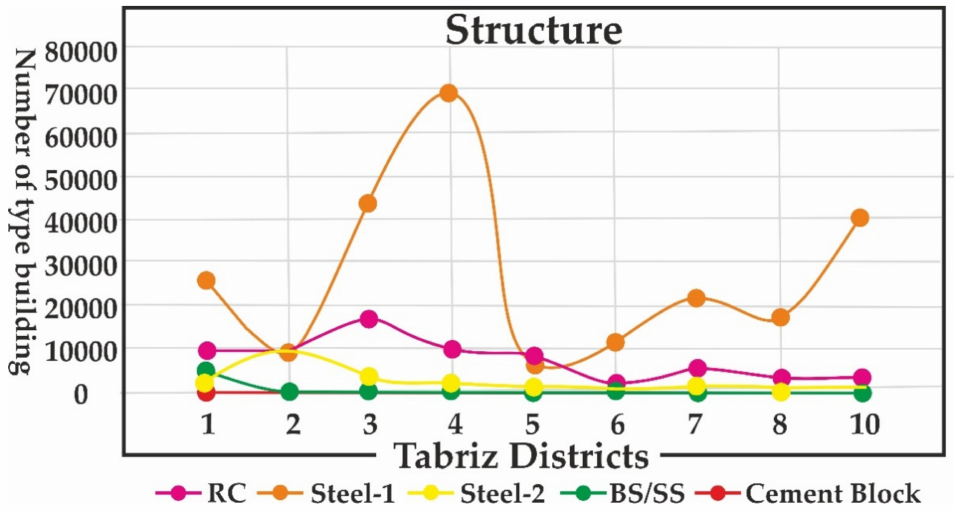
Figure 15. Diagram of the status of structures according to the districts of the Tabriz